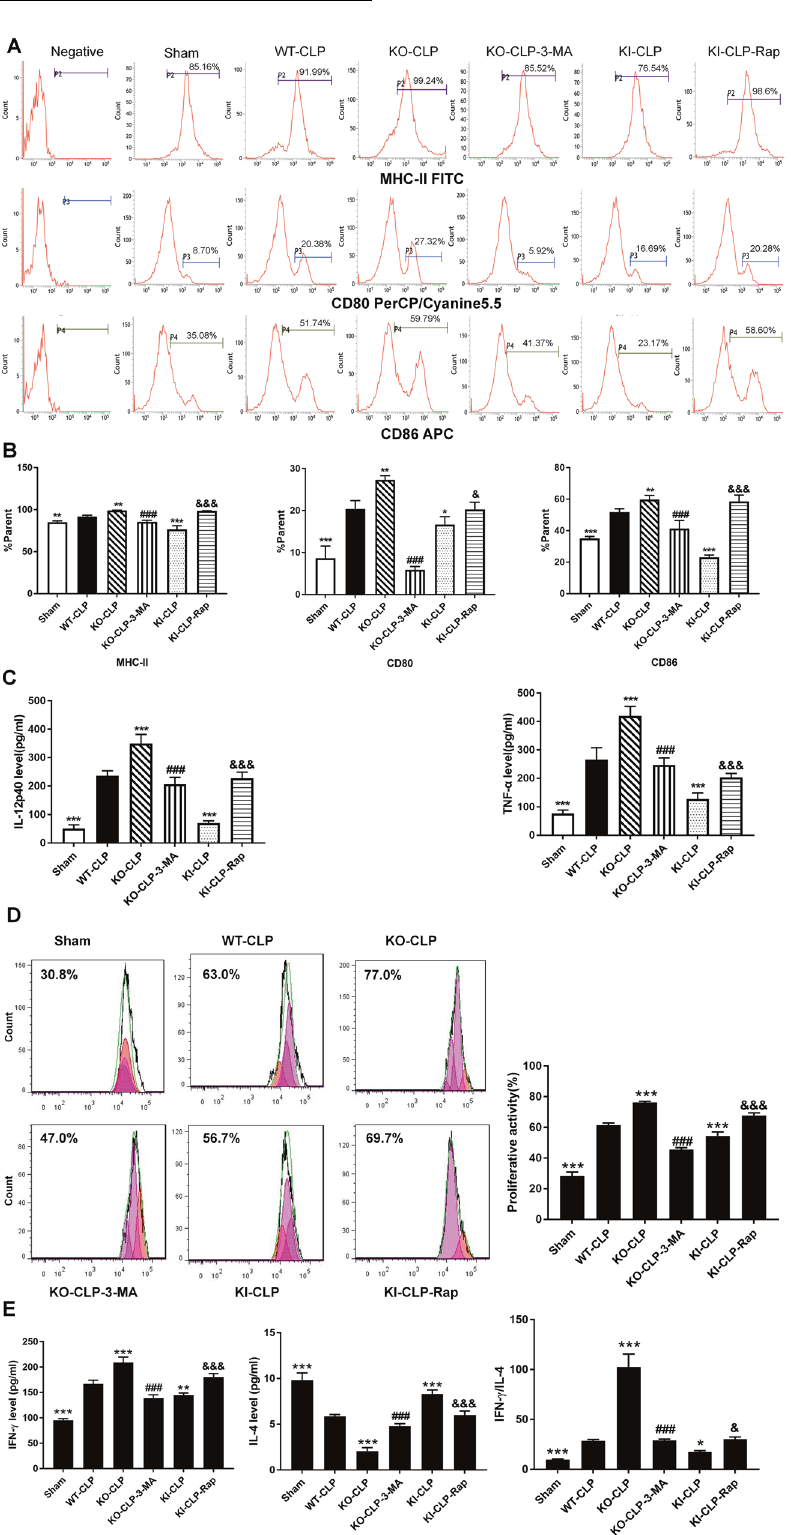
Fig. 6 Inhibitory effect of TIPE2 on the immune response of DCs in vivo. DCs were isolated from murine splenocytes in CLP or sham operation models with various TIPE2 genetic designs and divided into six groups. A , B Representative fl ow cytometric analysis of CD80, CD86, and MHC-II expressions on DCs in vivo. C Release of cytokines including IL-12p40 and TNF- α by DCs was measured by ELISA. D Proliferation of CD4 + T cells was examined by CFSE staining after incubating with DCs in a 100:1 ratio for 72 h. E IL-4 and IFN- γ levels in culture medium were determined by ELISA to evaluate Th1/Th2 polarization. Data of three independent experiments are represented as mean ± SD ( n = 6 in each group). Statistical signi fi cances: compared with the WT-CLP group, * P < 0.05, ** P < 0.01, *** P < 0.001; compared with the KO-CLP group, ### P < 0.001; compared with the KI-CL P group, & P < 0.05, &&& P < 0.001.